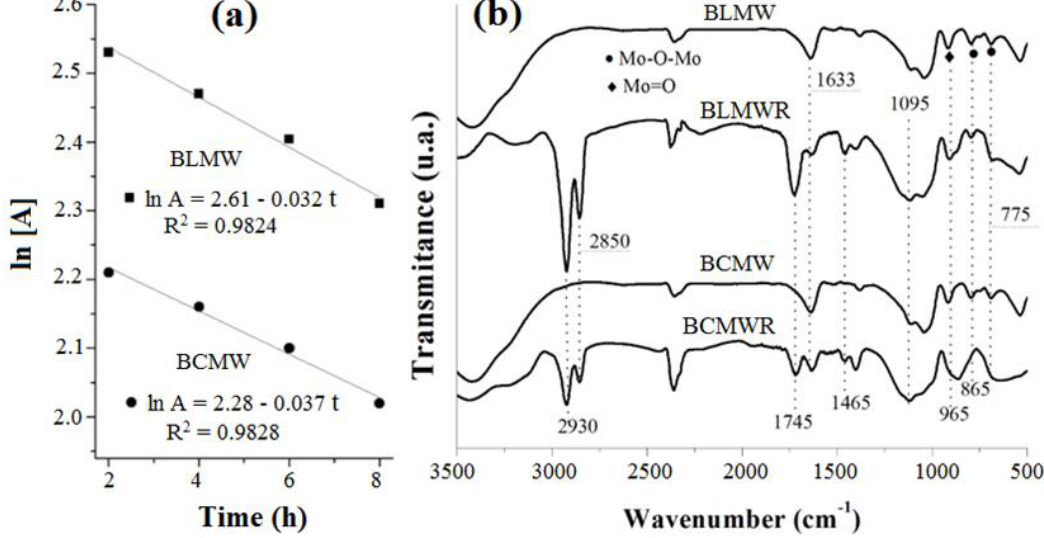
Figure 13. ( a ) Operational stability and plot of residual activity versus reaction time for the determination of inactivation constant and half-life; ( b ) FTIR spectrum for samples fresh BCMW, BLMW and before post-reuse BCMWR, BLMWR.